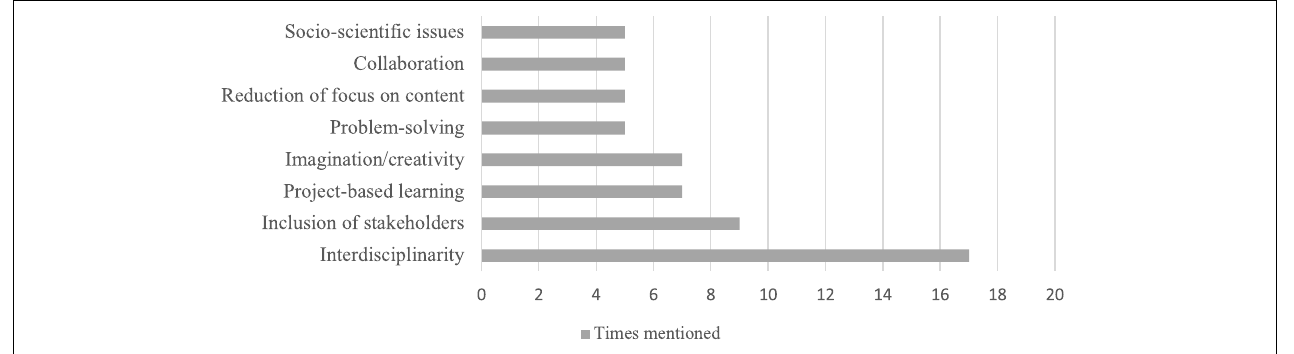
FIGURE 6 | Ways of introducing future-oriented competencies in science curriculum.